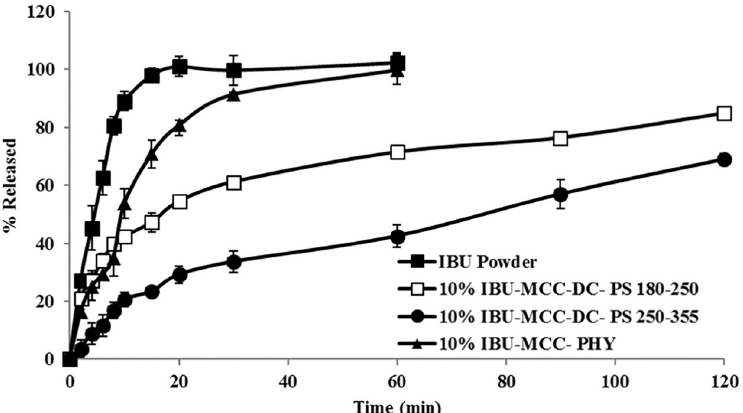
Fig 3. Comparison of dissolution profile of 10% w/w ( ▲ ) ibuprofen (IBU) with MCC physical mixture (PHY), dry coated particles (DC) with different carrier particle size (PS) ( □ ) 180–250 μ m and ( ● ) 250–355 μ m, and ( ■ ) ibuprofen (IBU) powder determined using USP Basket Method at 50 rpm measured in phosphate buffer pH 7.2 at 37˚C, (mean ± SD, n = 3).